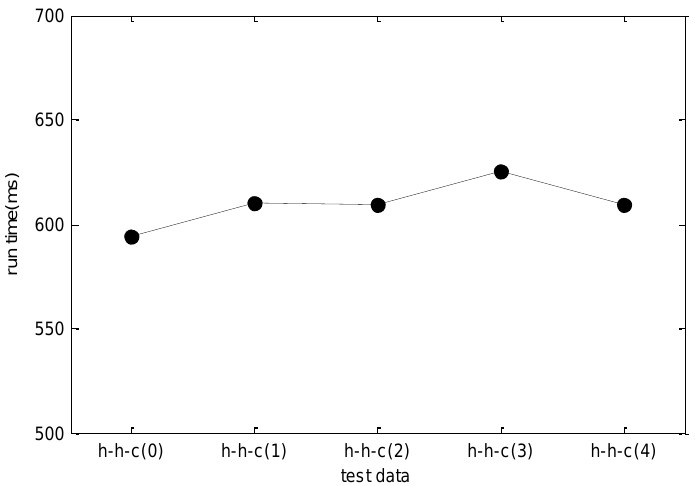
Figure 12. The runtime of DPSO-DA for five groups of h-h-c data.